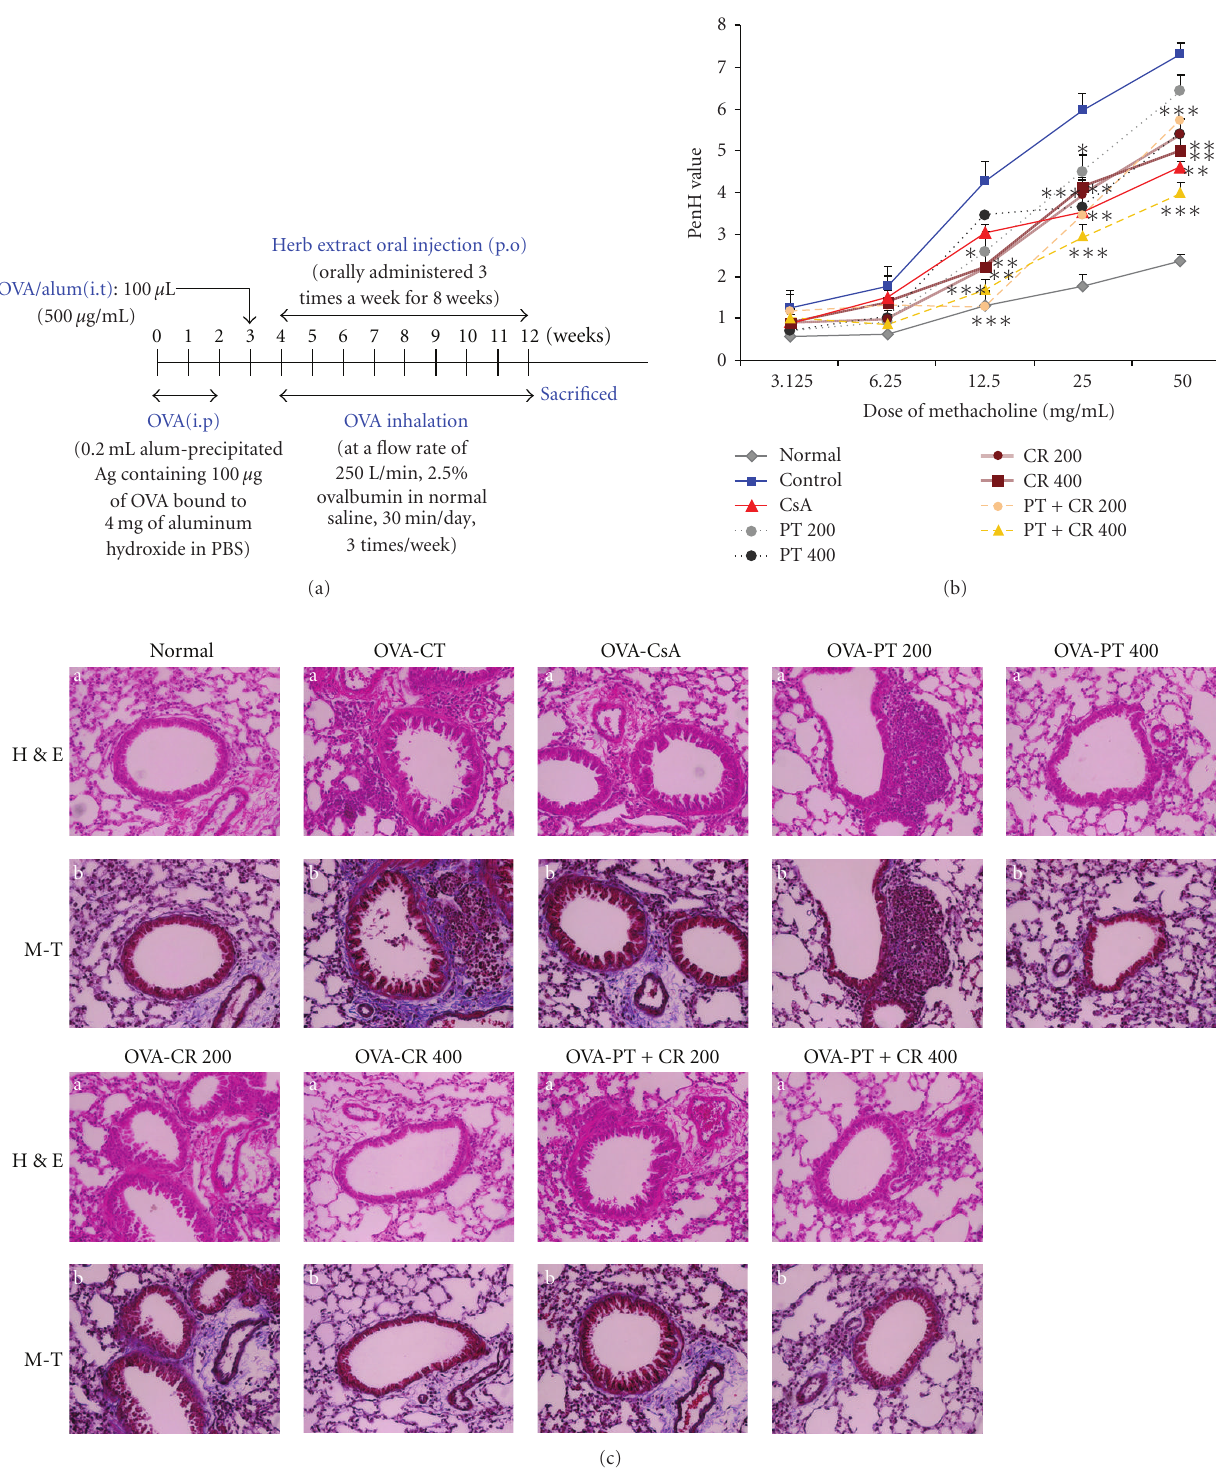
Figure 1: (a), Schematic diagram of methacholine-induced AHR in the sensitization protocol. (b), PenH was measured in a Buxco box, as previously described in materials and methods. ∗ P < . 05, ∗∗ P < . 01, ∗∗∗ P < . 001 asthma goup (control) versus PT, CR and their combinational prescription treated groups. (c), E ff ect of PT, CR and their combinational prescription on histology of lung tissue (H&E and M-Tstaining) in lung cells of OVA-induced murine model of asthma. H and E: hematoxylin-eosin stain, M-T: Masson trichrome stain, The results are expressed the mean ± S.E ( N = 5). Statistically significant value compared with control group data by ANOVA ( ∗ P < . 05, ∗∗ P < . 01, ∗∗∗ P < . 001). N: Normal Balb/c mice, CT: Ovalbumin inhalation (control), OVA + CsA (10mg/kg), OVA + PT(200, 400mg/kg), OVA + CR(200, 400 mg/kg), OVA + (PT + CR) (200,